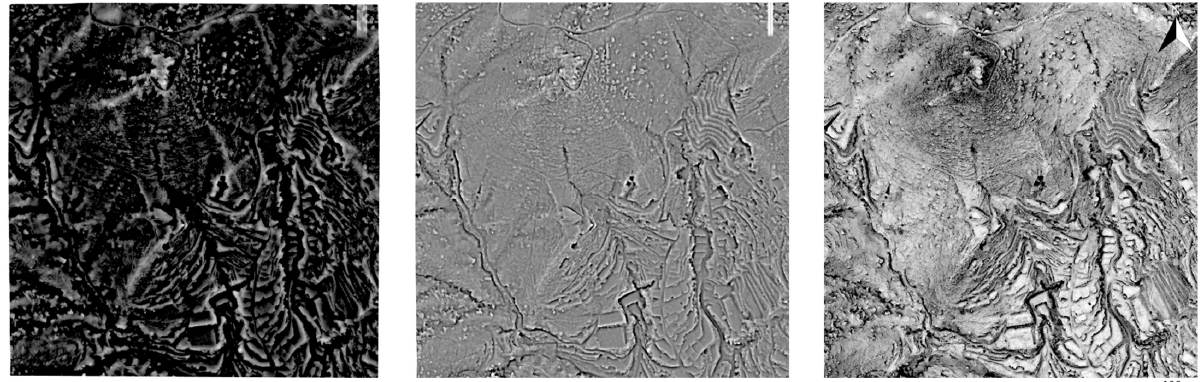
Figure 5. Comparison for the Burriac settlement of the different visualization algorithms, which have been shown to be better for the case study: MSRM, SLRM, and SVF (from left to